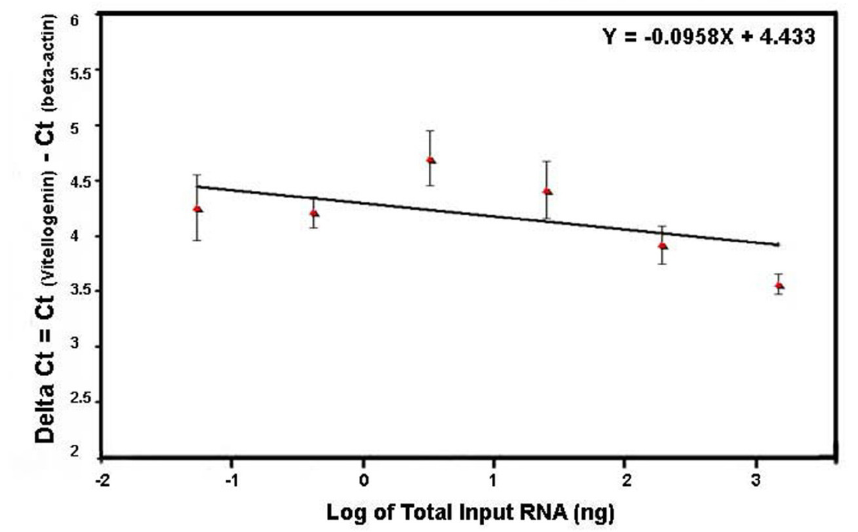
Figure 7. Validation of amplification efficiency for vitellogenin and β -actin by SYBR Green qRT-PCR. The amplification of six five-fold dilutions of total RNA ranging from 1 μ g to 0.32 ng per reaction was performed in triplicate and the standard curves for vitellogenin and β -actin were generated by plotting the C value against the corresponding T input RNA. The difference between the C value of vitellogenin and that of β -actin ( Δ Ct) T was versus the log of the corresponding amounts of input